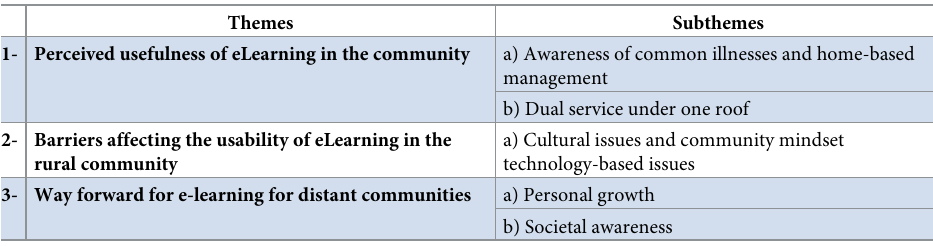
Table 2. Themes and Subthemes of the